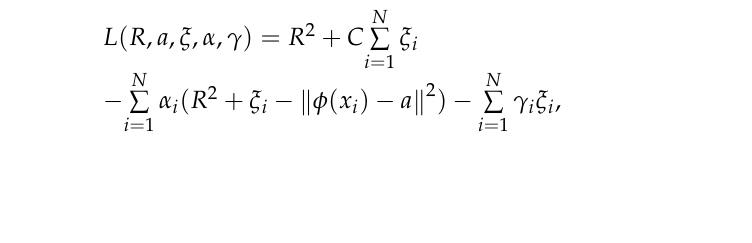
Figure 6. Time ‐ domain waveform and envelope spectrum of the original; ( a ) time ‐ domain waveform; ( b ) spectral envelope.